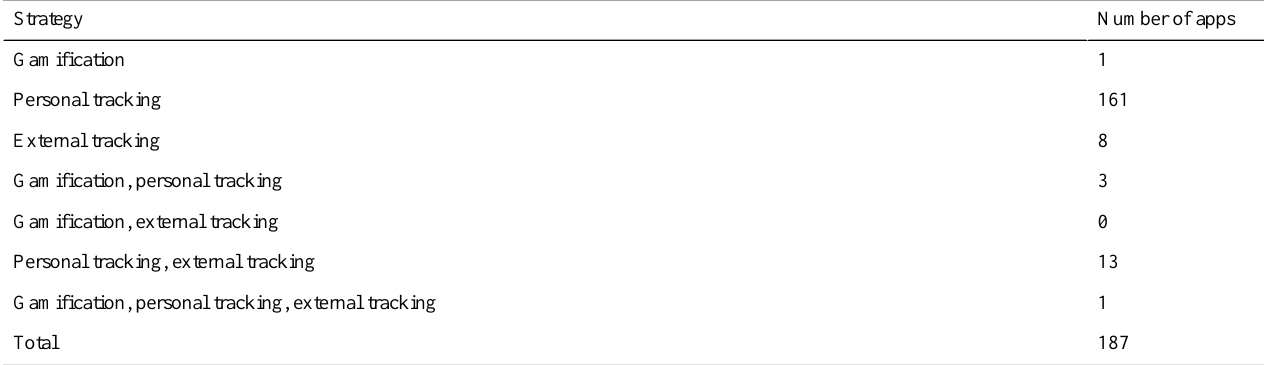
Table 3. Number of apps adopting behavioral strategies.